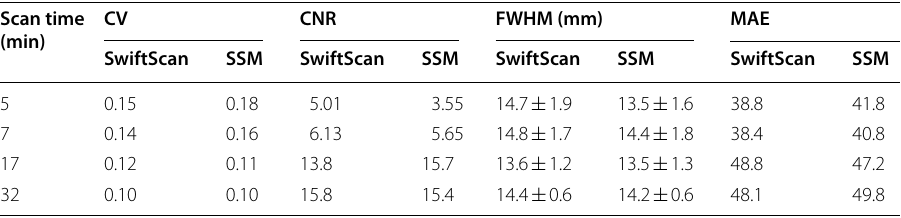
Table 1 Comparison of image quality indices and quantitative accuracy between SSM and SwiftScan